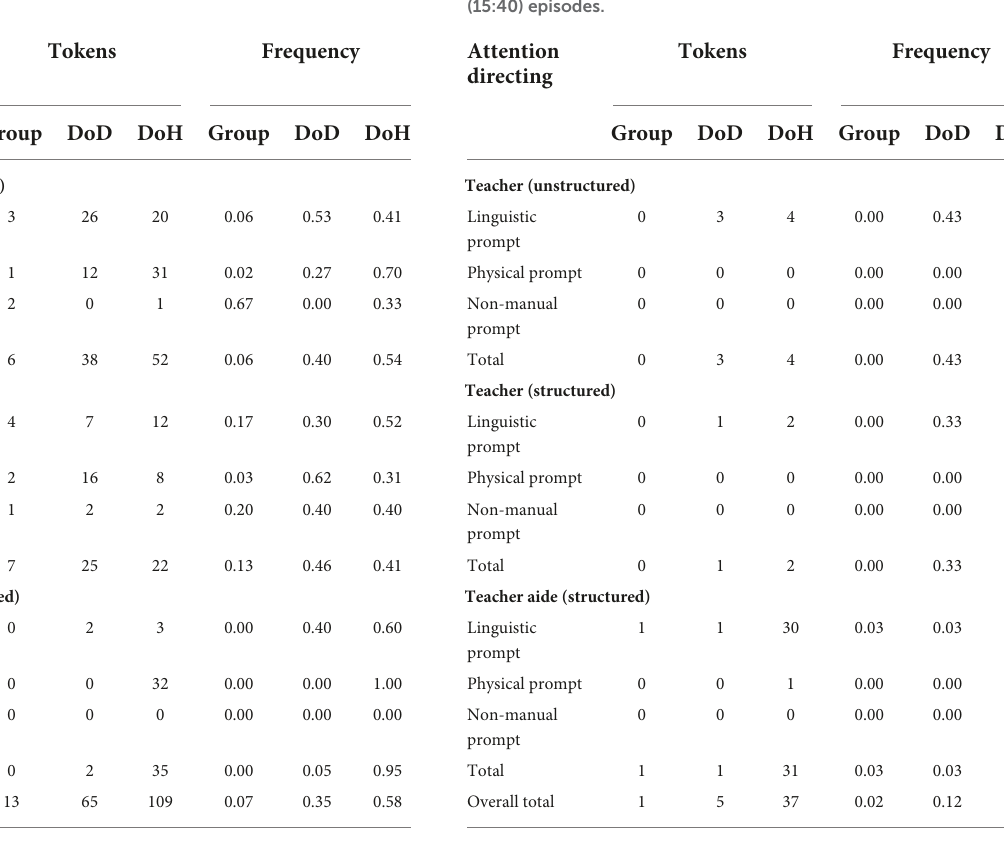
TABLE 6 Teacher and teacher aide attention directing actions in the unstructured picture walk (21:33) and structured role play (15:40)